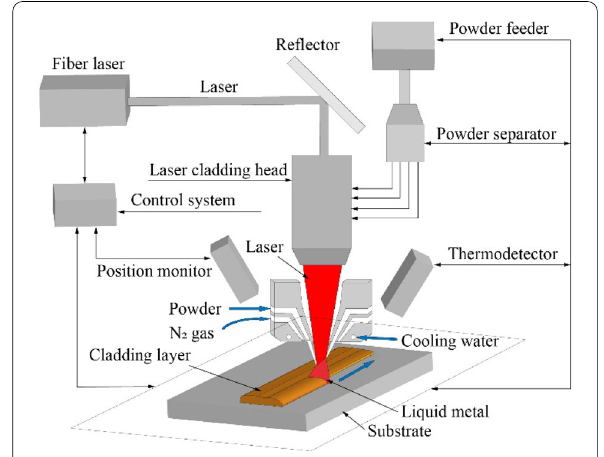
Figure 1 Schematic of laser